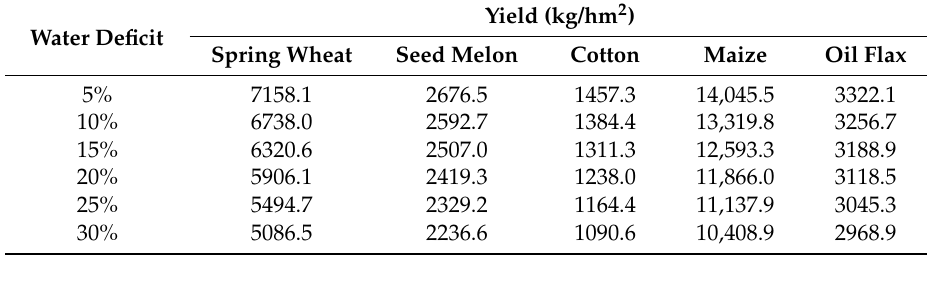
Table 7. Summary of typical crop yields at different levels of water deficit.